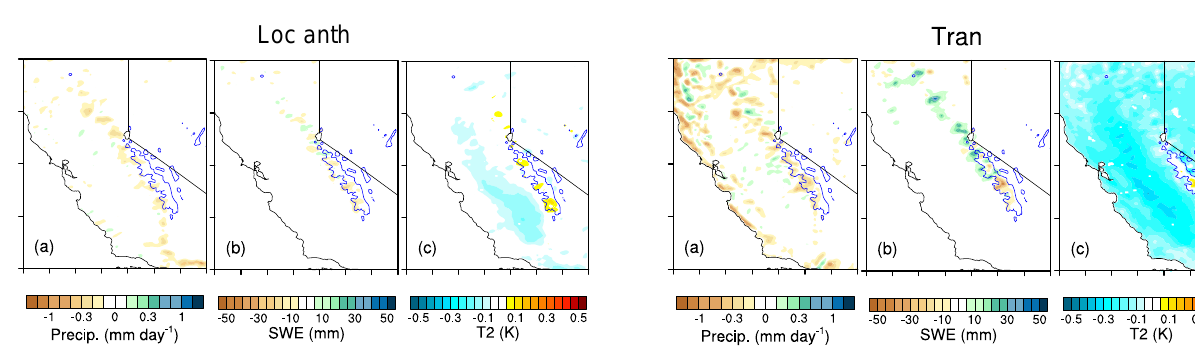
Figure 12. Same as Fig. 10, but for the effect of transported aerosols (CTRL –